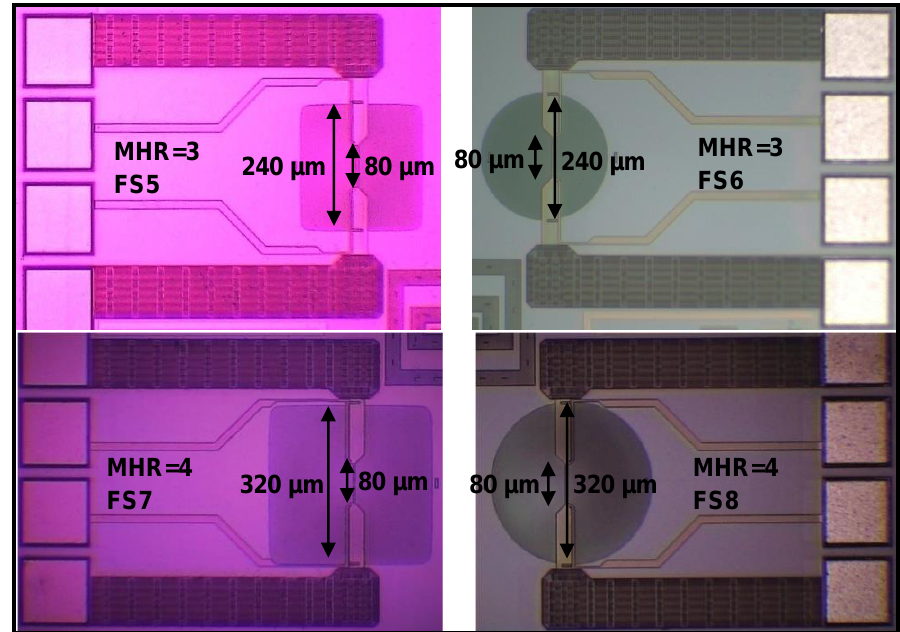
Figure 4. Optical micrographs (top view) of fabricated hot-film flow sensors having membrane to heater ratio 𝑀𝐻𝑅 = 3 (FS5 and FS6).